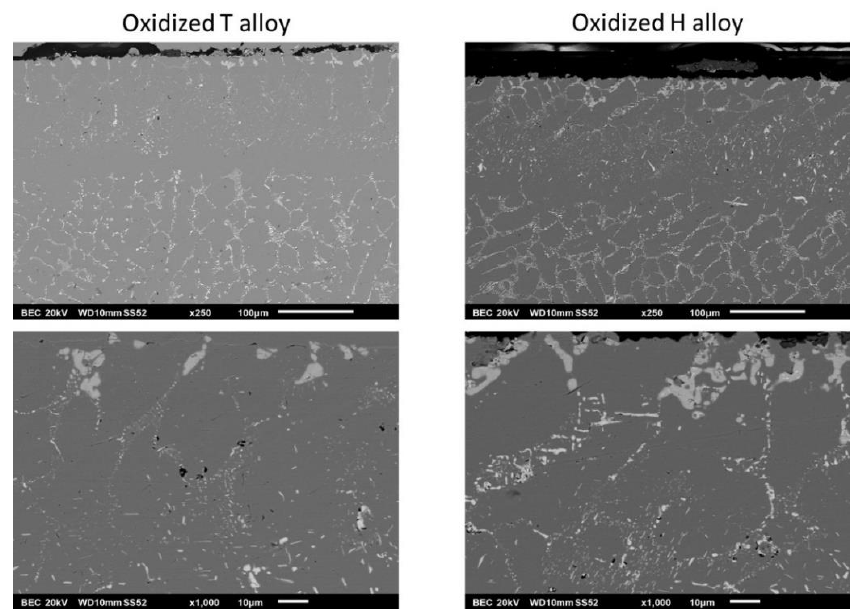
Figure 10. Cross-sectional observation of the surfaces and sub-surfaces affected by oxidation for the two alloys ( left : T alloy, right : H alloy, top : general view, bottom : detailed view).